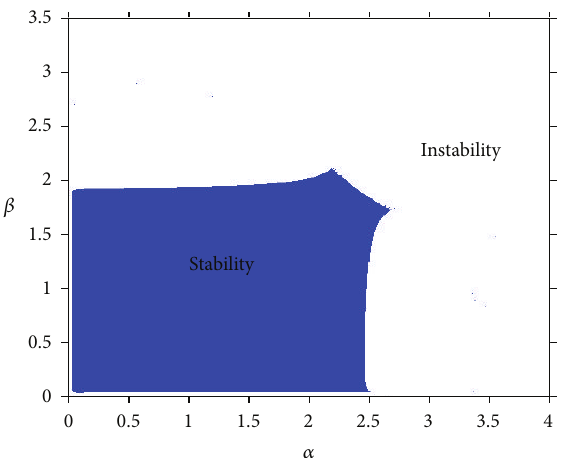
Figure 1: The stability and instability region.